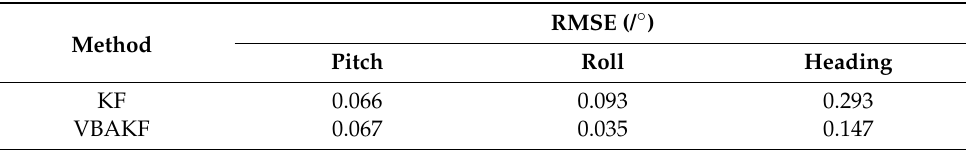
Table 5. The RMSE result of the three-dimensional attitude estimation errors of the interference evaluation and multi-mode switching algorithm.